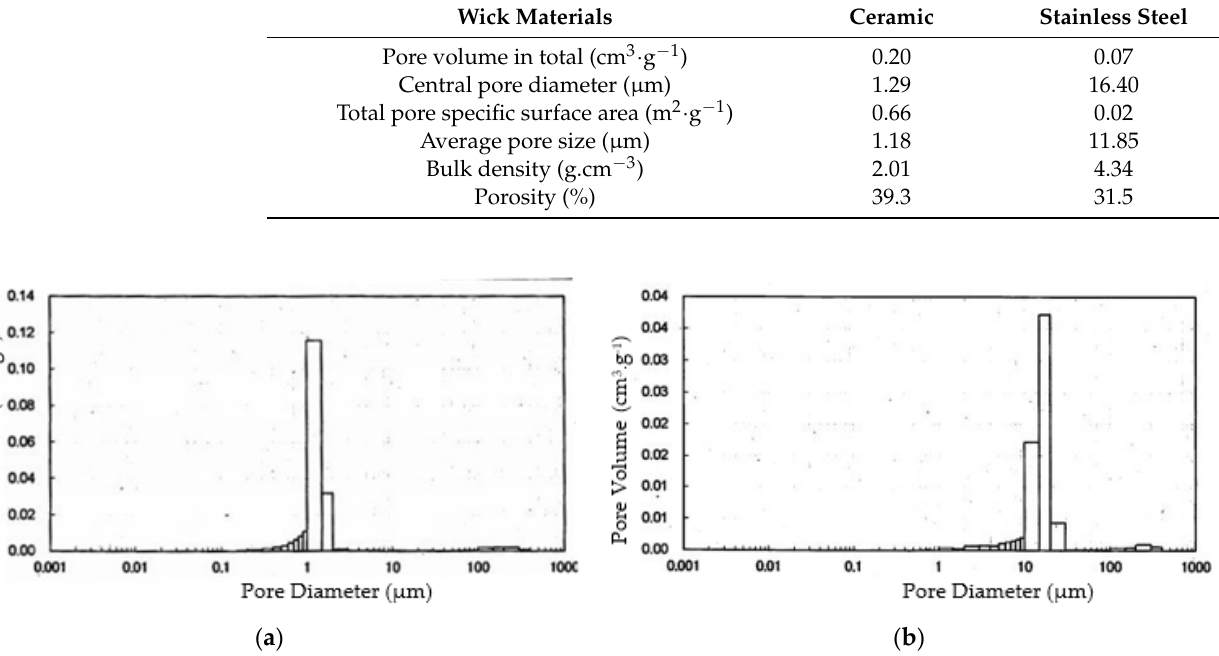
Figure 10. Pore frequency distribution graphs ( a ) Ceramic wick ( b ) Stainless steel wick. Reproduced from [25], Saga Ceramics Research Laboratory: 2019.